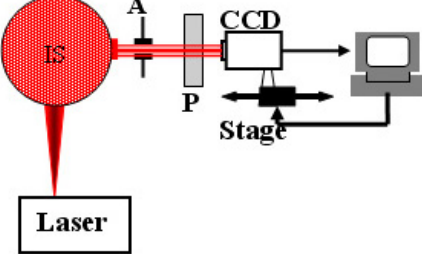
Fig. 1. Experimental setup (A – is a single slit square shaped aperture, P – is a plane polarizer, IS – is an integrating sphere).